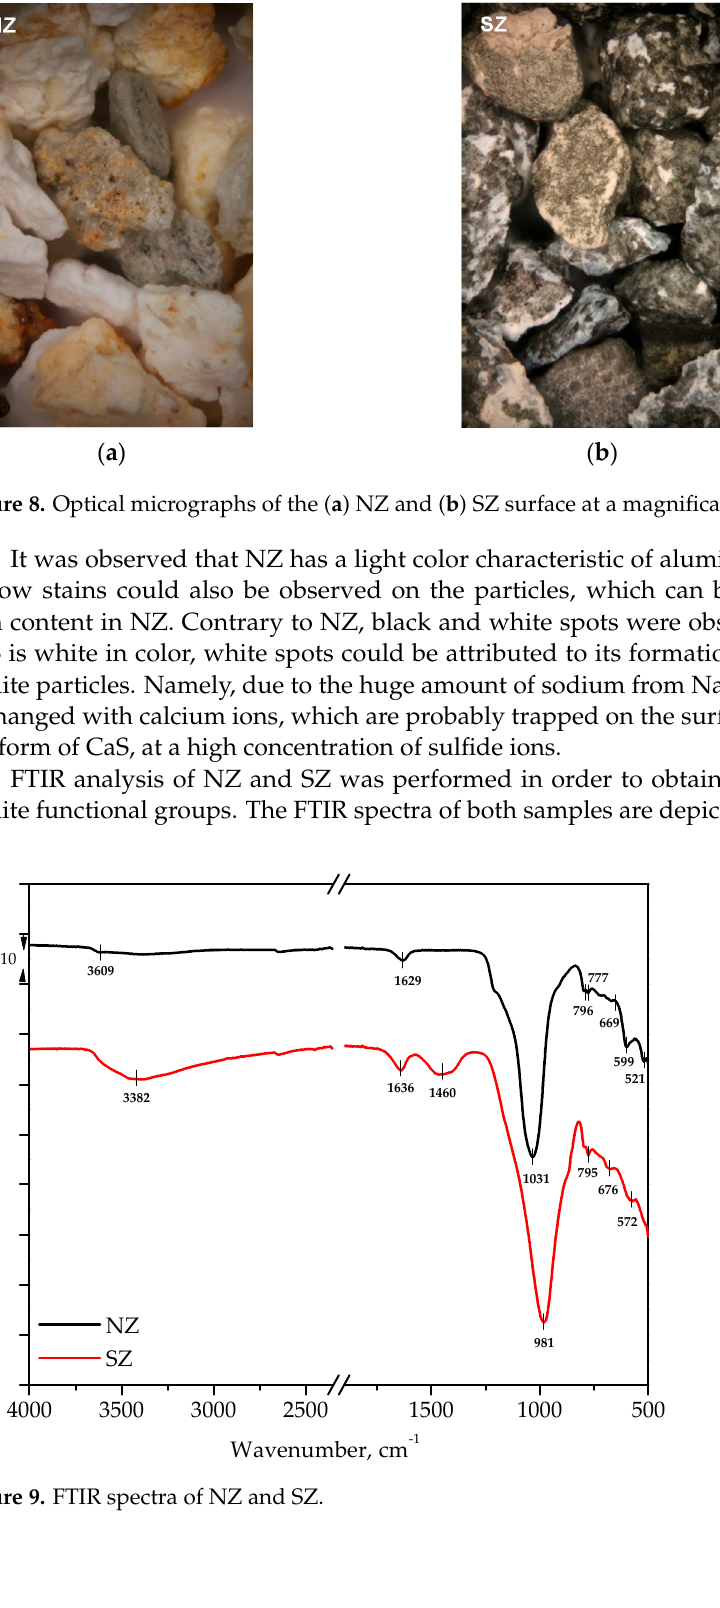
Figure 7. Photographs of ( a ) NZ and ( b ) SZ samples.